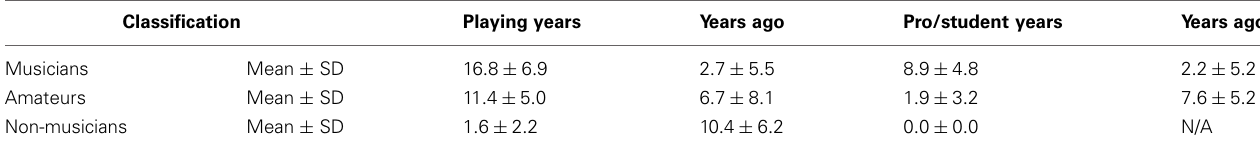
Table 2 | Musical